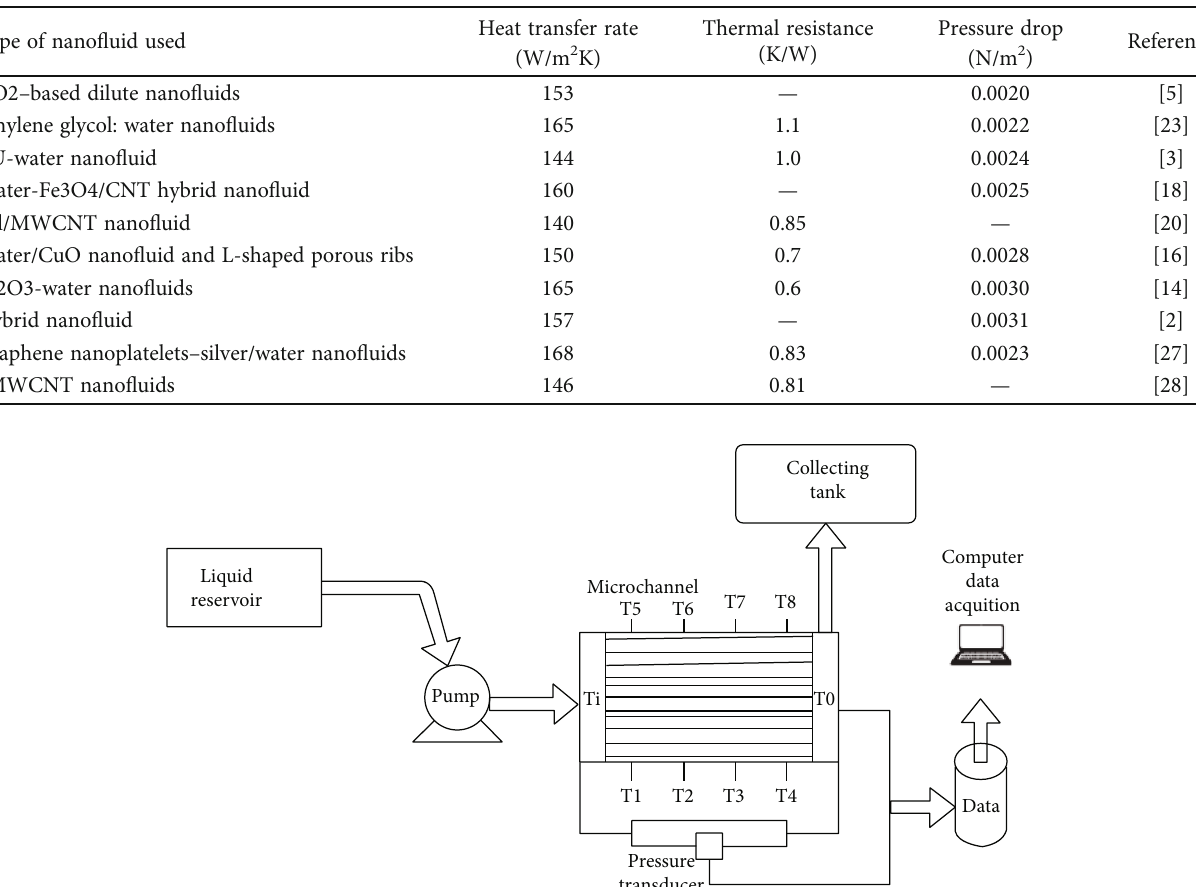
Table 1: Performance of microchannel used with various nano fl uid additives.